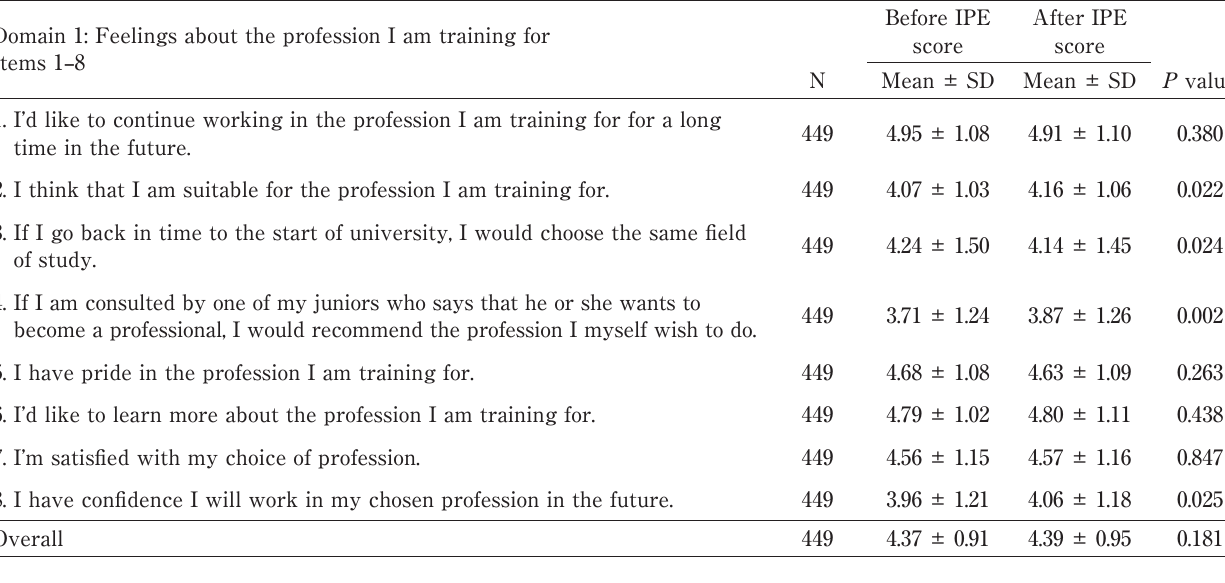
Table 2. Comparison of the scores before and after IPE in domain 1